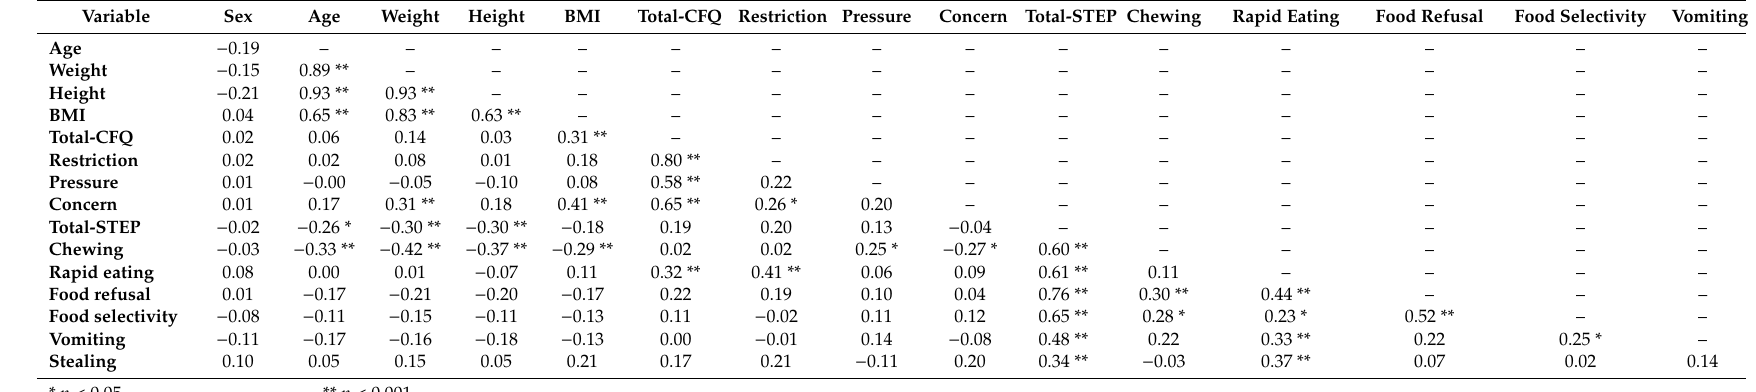
Table 10. Spearman’s rank correlation coefficients (r) of physical status, child feeding problems and parent-child feeding relationship variables in the participants (n = 78).